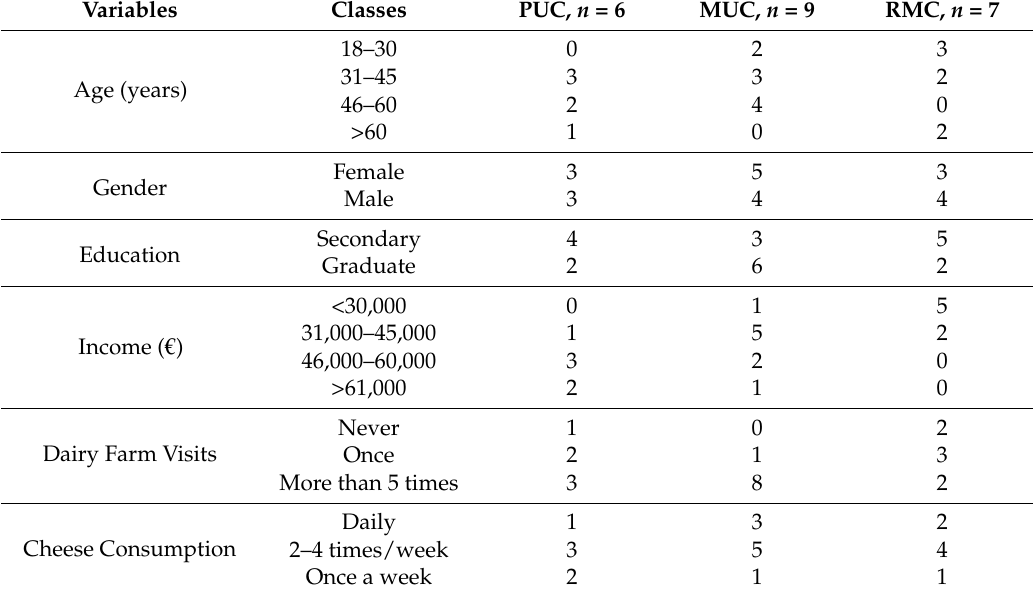
Table 1. Socio-economic characteristics and cheese consumption habits of plain urban consumers (PUC), mountain urban consumers (MUC), and rural mountain consumers